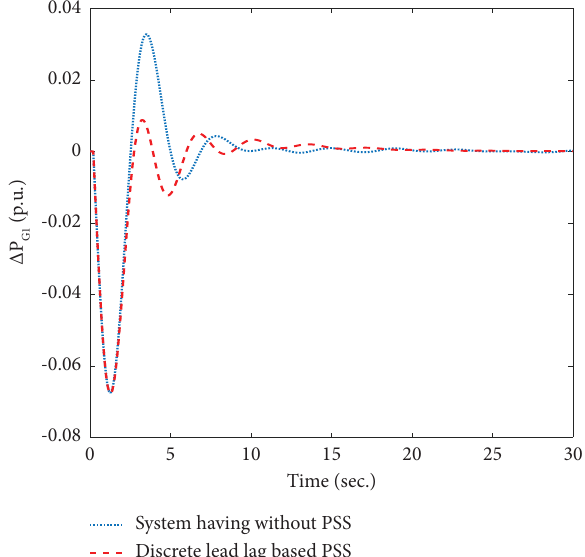
Figure 6: Power deviation in governor of area-1 Δ P respect to time (sec) for without having any PSS and with the discrete lead-lag-based g 1 (p.u.) with